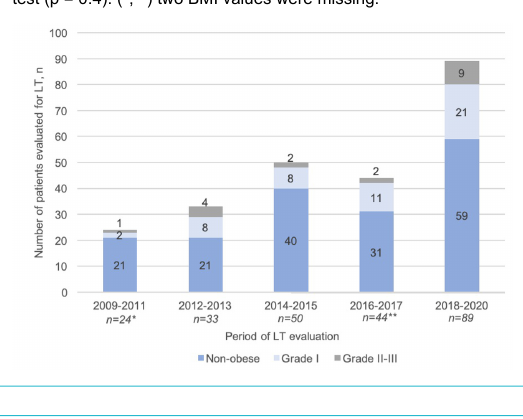
Figure 4: Evolution of type 2 diabetes mellitus prevalence over time. Frequency of type 2 diabetes mellitus among patients evalu- ated for liver transplantation (y axis) over time (x axis) is represent- ed by columns and was compared using chi-square tests (p =